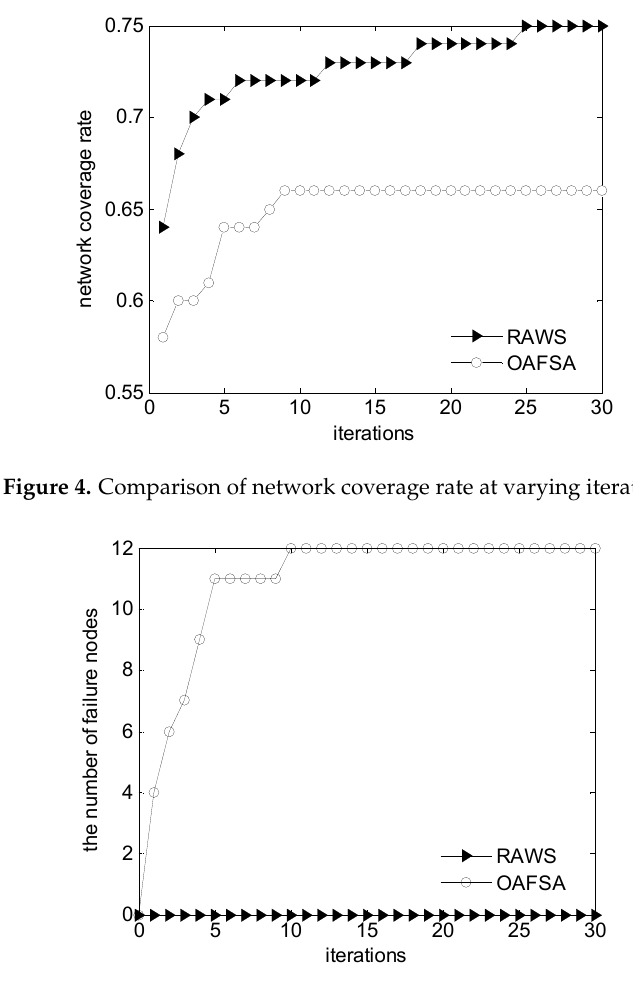
Figure 5. Comparison of the number of ineffective nodes at varying iterations.